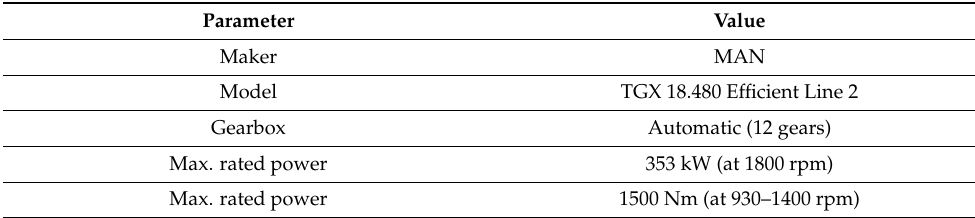
Table 1. Main specifications of tested